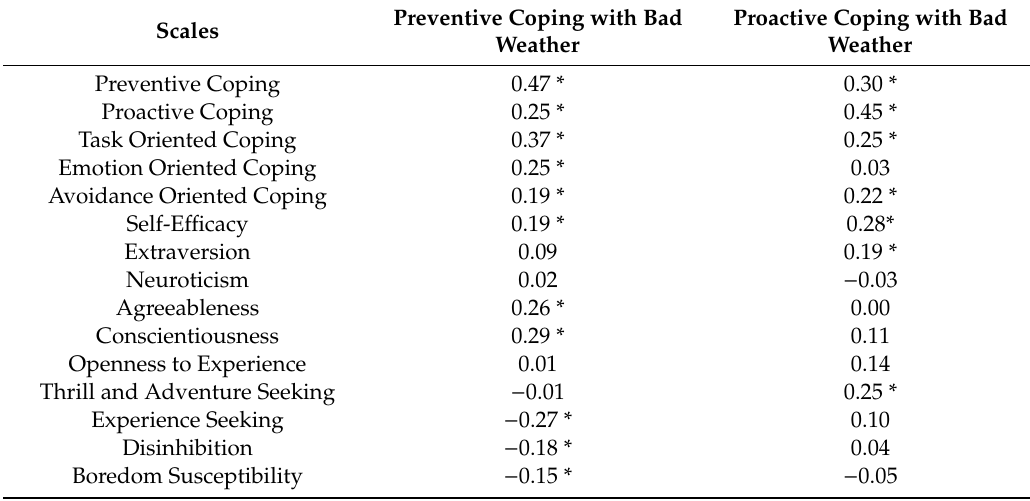
Table 3. Correlations between the coping scales, the Self-E ffi cacy Scale, the NEO-FFI Scale, the Sensation Seeking Scale, and the Preventive and Proactive Coping with Bad Weather in Outdoor Sports Scale.